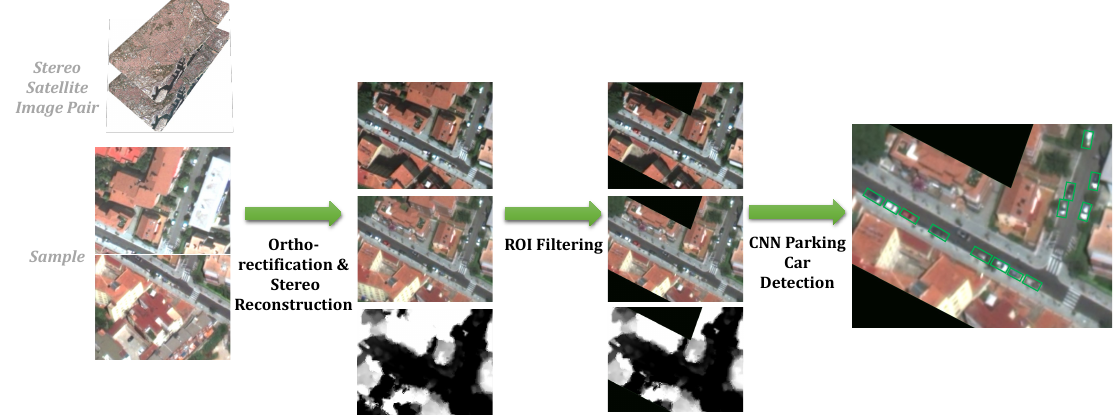
Figure 1. Overview of our proposed methodology for detecting parking cars in satellite images. The results of the individual steps are shown for a small sample region.